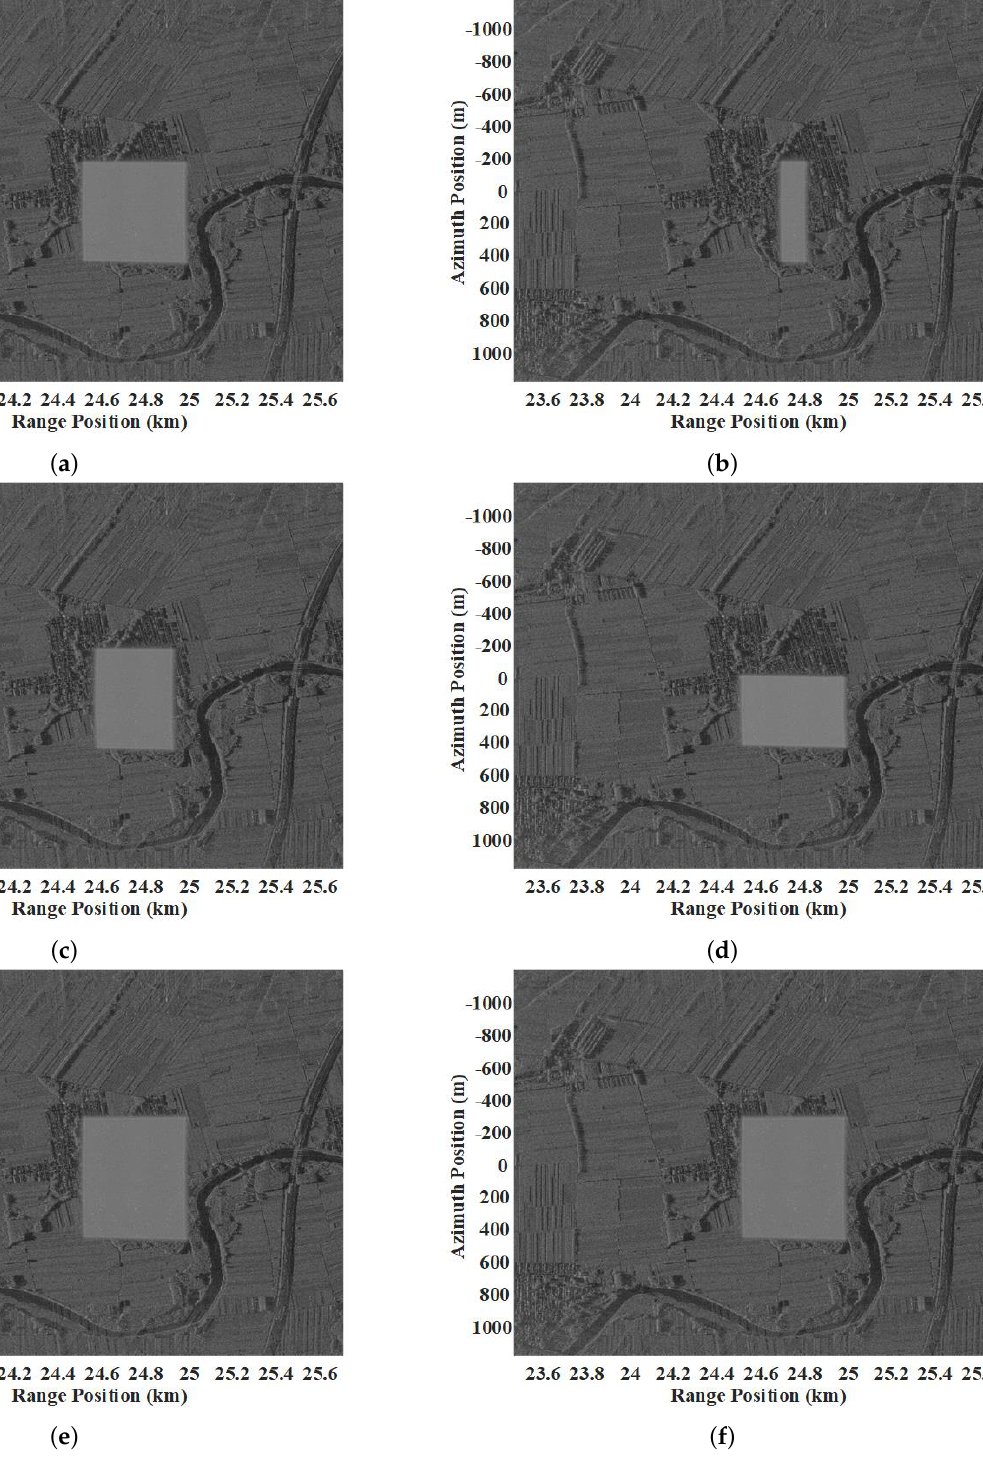
Figure 10. Imaging results of suppression jamming signal under different reconnaissance